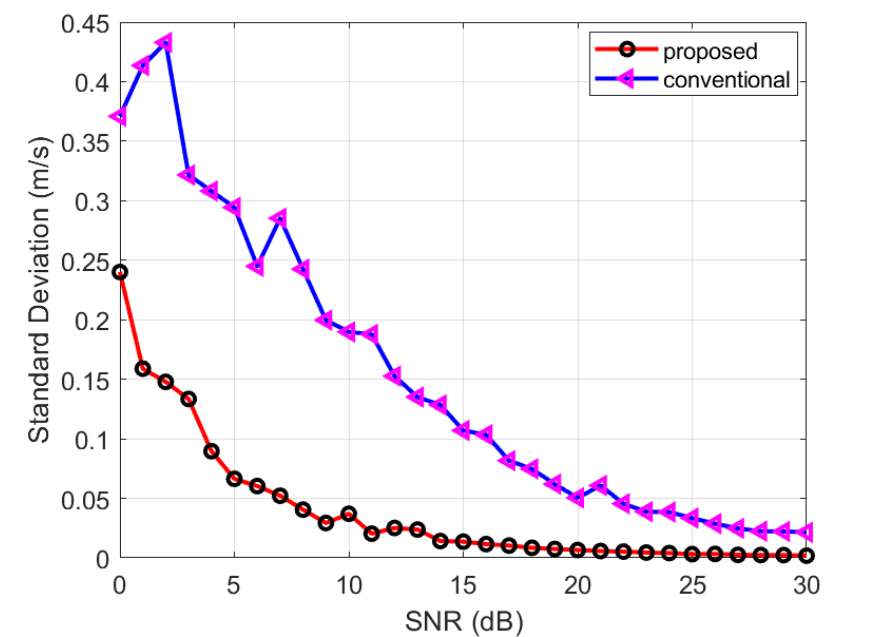
Figure 7. Comparison of standard deviation of 50 estimated current velocity with SNR of 15